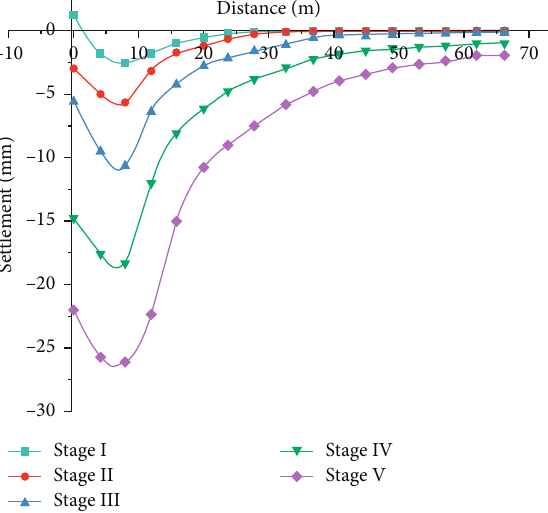
Figure 9: Surface settlement